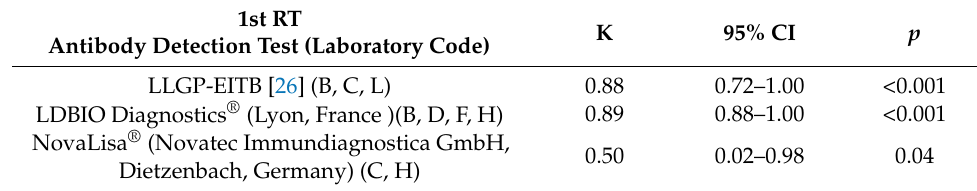
Table 7. Inter-rater agreement of serological Ring Trials (RT).